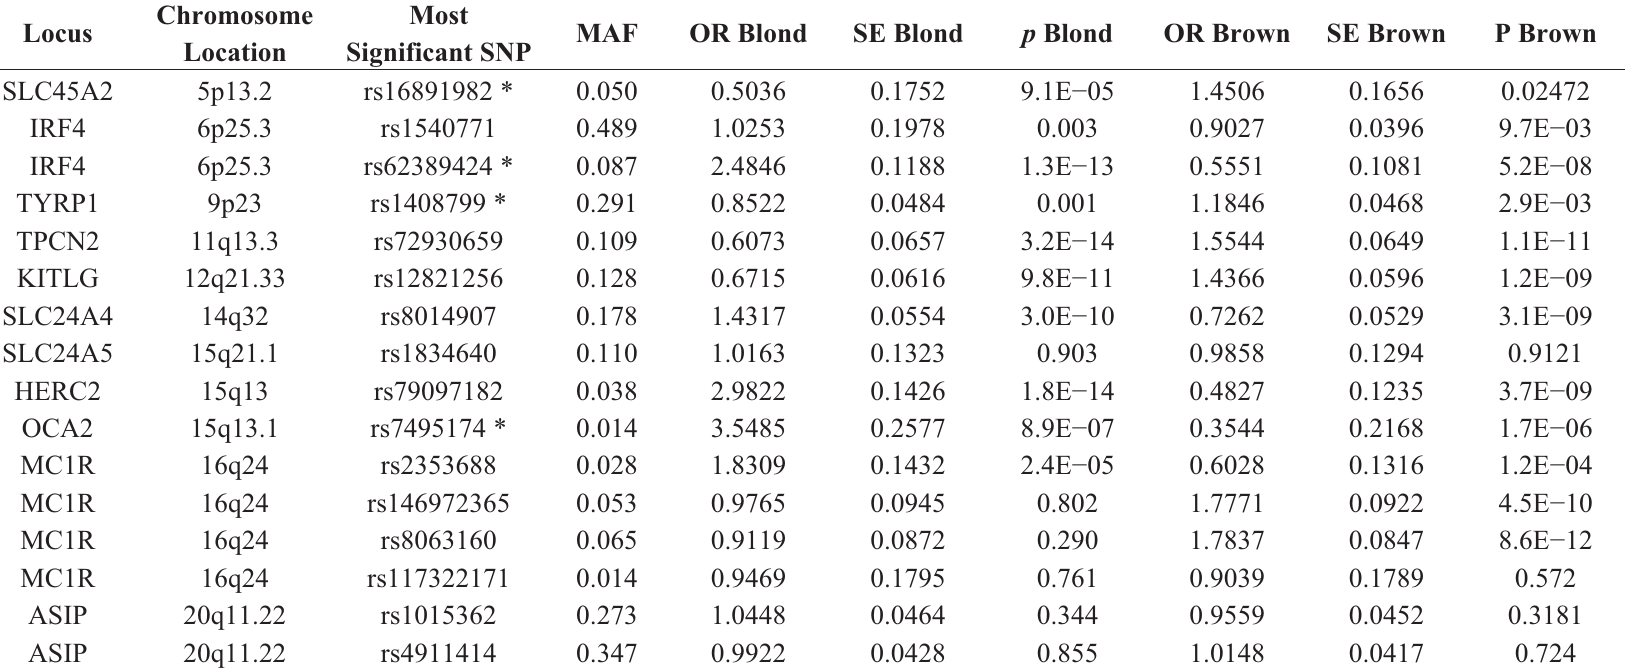
Table 5. SNP associations within our study for blond and brown hair against known hair color